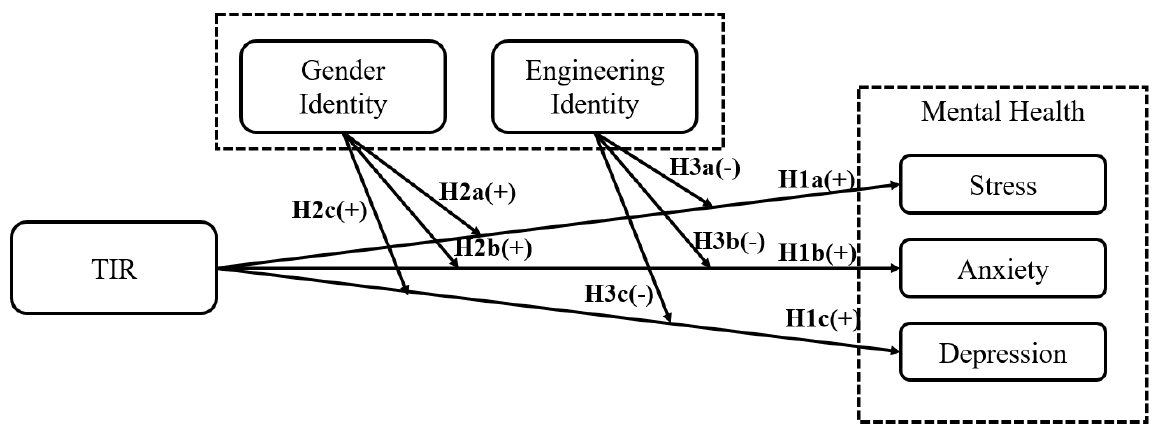
Figure 2. Conceptual model of possible relationships among the tension of interpersonal relationships, mental health distress, gender identity, and engineering identity.